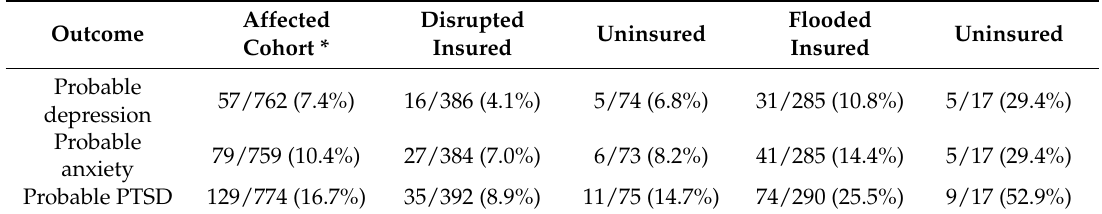
Table 1. Crude proportions of mental health outcomes by those who were insured and uninsured ± . Affected Outcome Cohort *